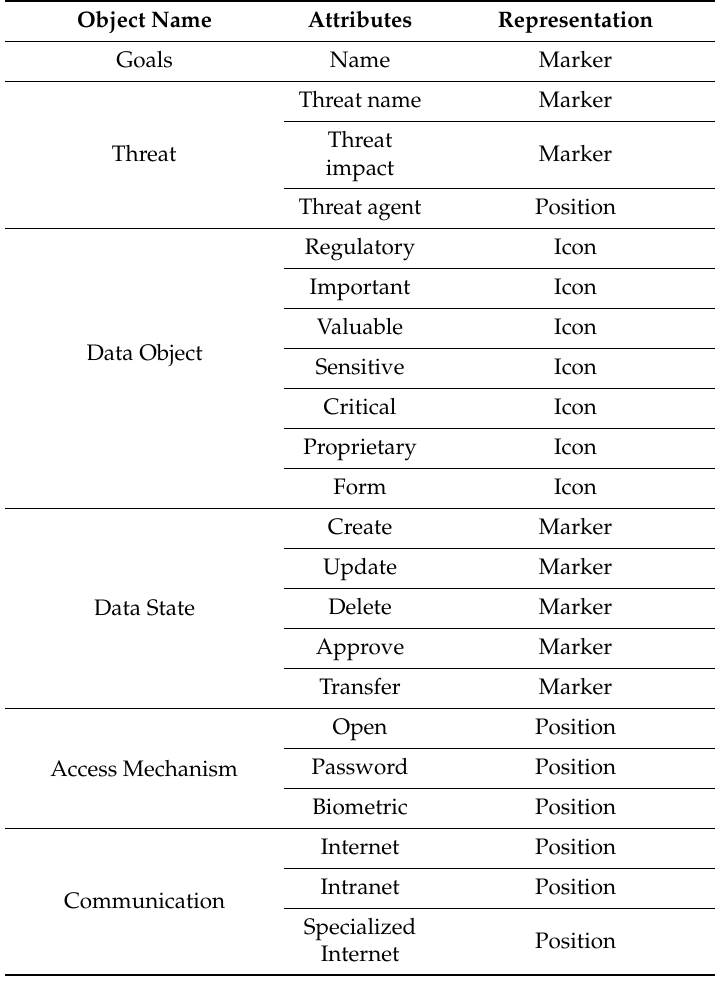
Figure 7. Visual representation of security goal and impact of threat on goal in the BPMN extension. ( a ) security goal symbol, ( b ) high threat of impact on goal, ( c ) low impact of threat on goal. 4. Table 3. Attributes of extended security objects in BPMN.